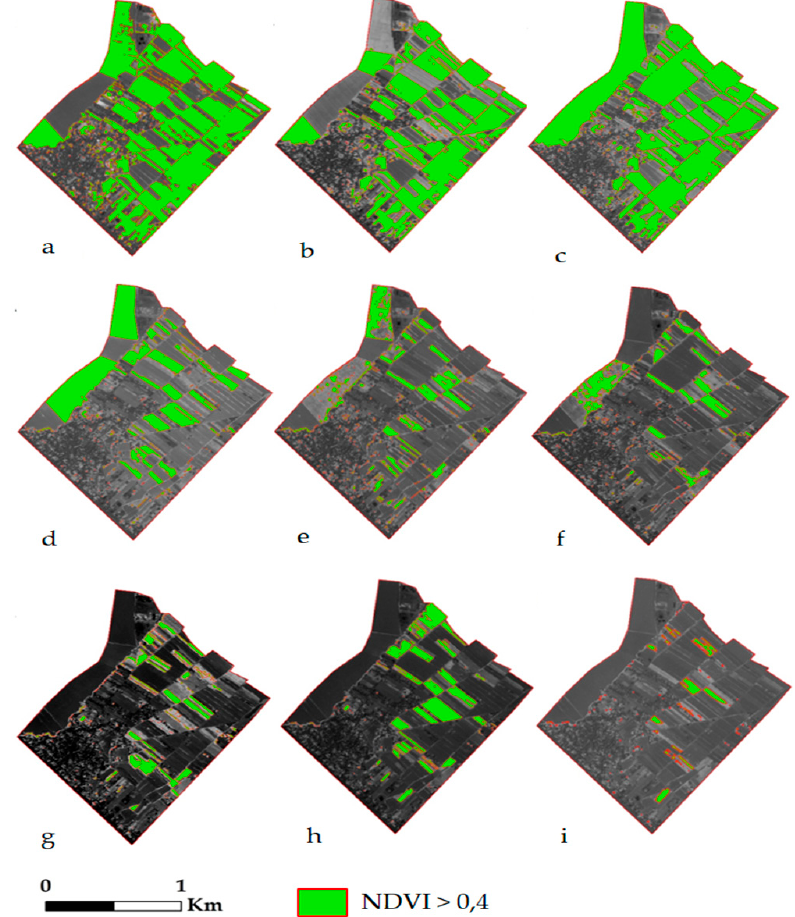
Figure 3. Extract of the NDVI value evolution above 0.4 in the Bekaa Valley in 2017 (sample). a : March; b : April; c : May; d : June; e : July; f : August; g : September; h : October; i : November.